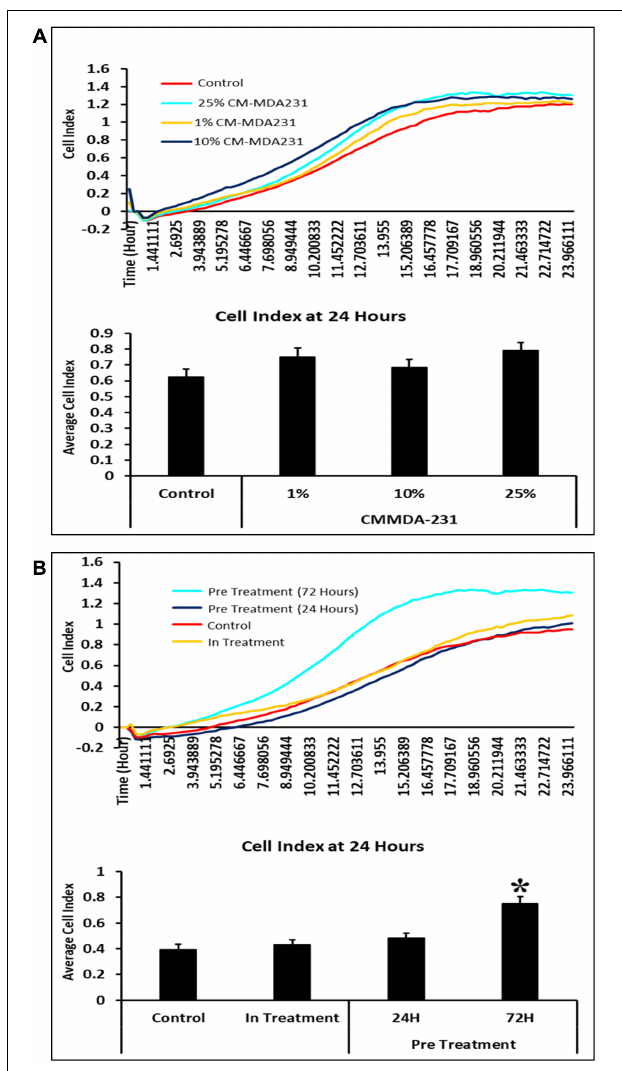
FIGURE 4 | Comparison of functional outcome of CV-MSCs before and after CM-MDA231 preconditioning. Migration analysis assessment by xCELLigence system after cells were treated with 1–25% of CM-MDA231 for 24 h (In-treatment) while performing the assay. As shown, CV-MSC migration at any of the treatment conditions (1–25%), did not change as compared to untreated control (A) . However, significant increase in migration was observed in CV-MSCs preconditioned for 72 h as compared to cells preconditioned for 24 h, as well in the in-treatment conditions (at 25% CM-MDA231 concentration, while performing the assay) and untreated control cells (B) . Experiments were performed in triplicate using cells at passage 3 prepared from five individual placentae. Bars represent standard errors * P ≤